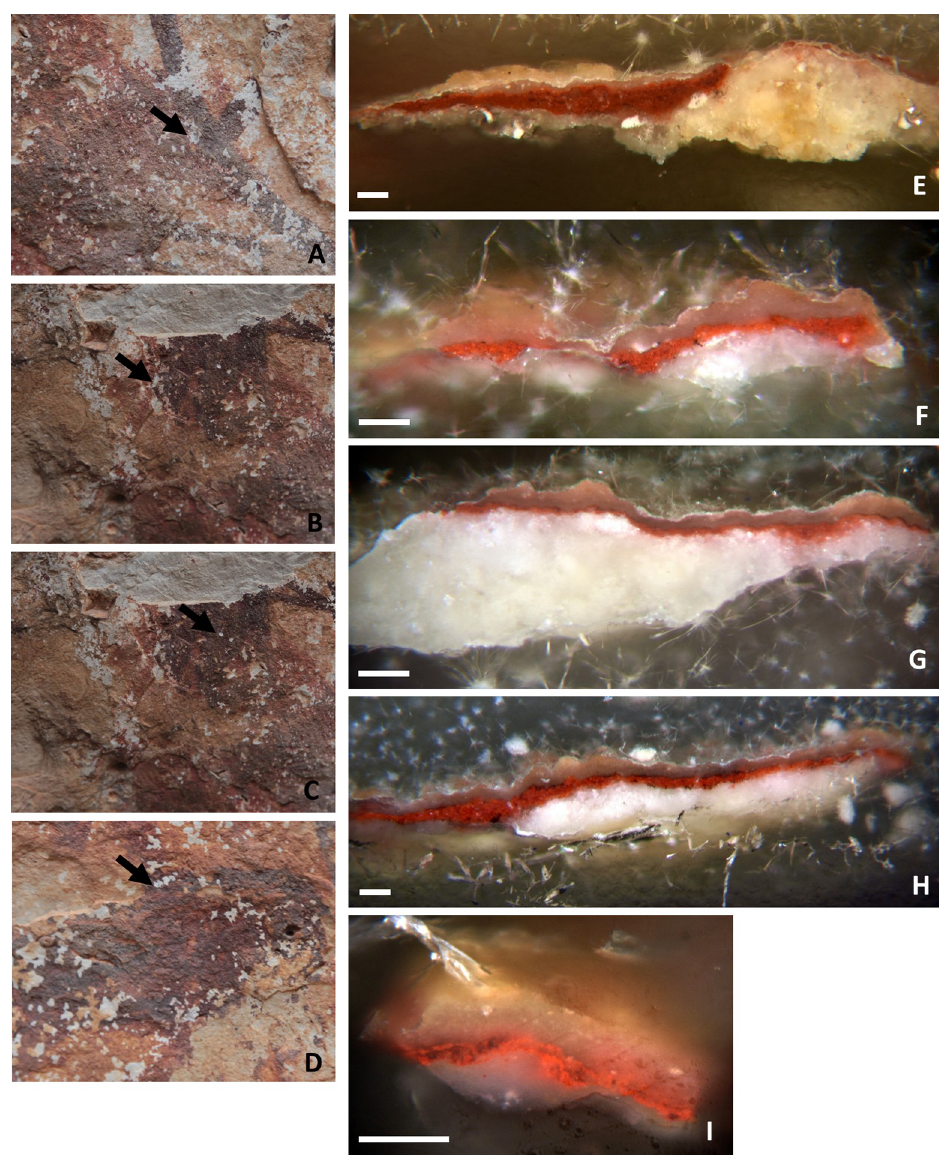
Fig 3. A-D: Location of the sampling areas before extraction. E-I: Optical microscope images of the cross-sections of the micro-samples collected in A-D. Images: A, E correspond to sample AC1; B, F and G correspond to samples AC2.1 and AC2.2; C, H correspond to sample AC3; D, I correspond to sample AC4. Scalebar = 100 μ m.